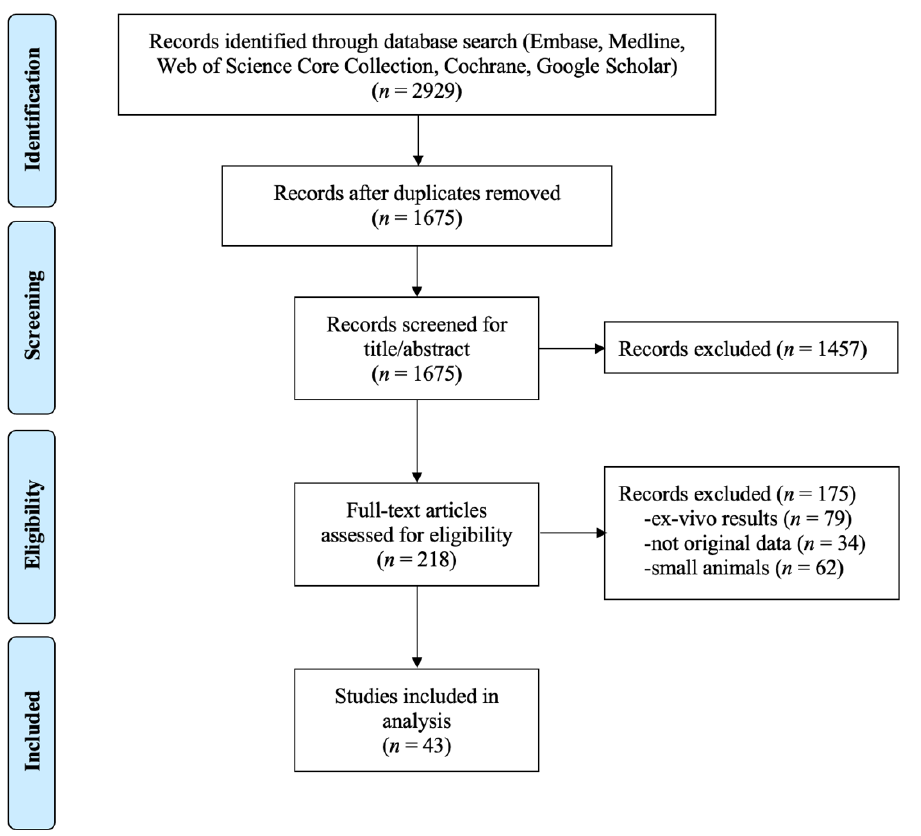
Figure 2. PRISMA flow